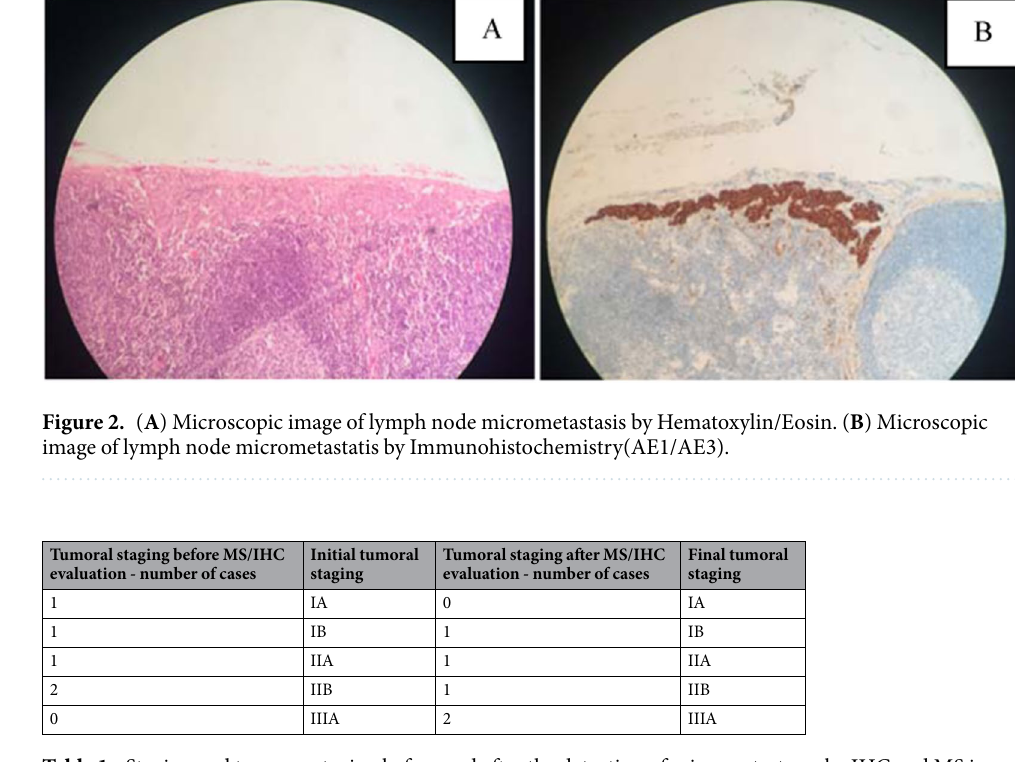
Table 1. Staging and tumor restaging before and after the detection of micrometastases by IHC and MS in patients operated for gastric cancer without lymph node metastases by hematoxylin-eosin (n = 5). MS – Lymph node multisection, IHC –